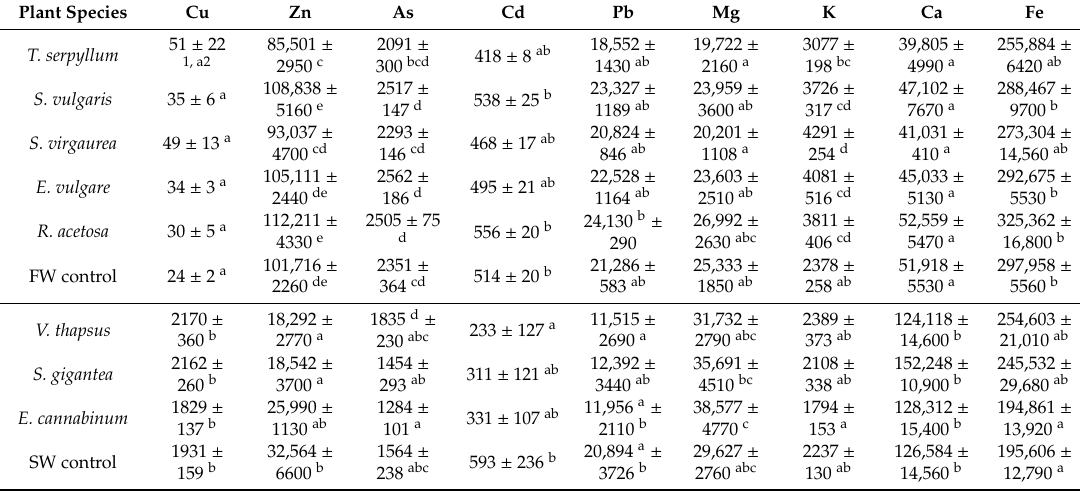
Table 2. Total metal contents in FW and SW soils (mg kg − 1